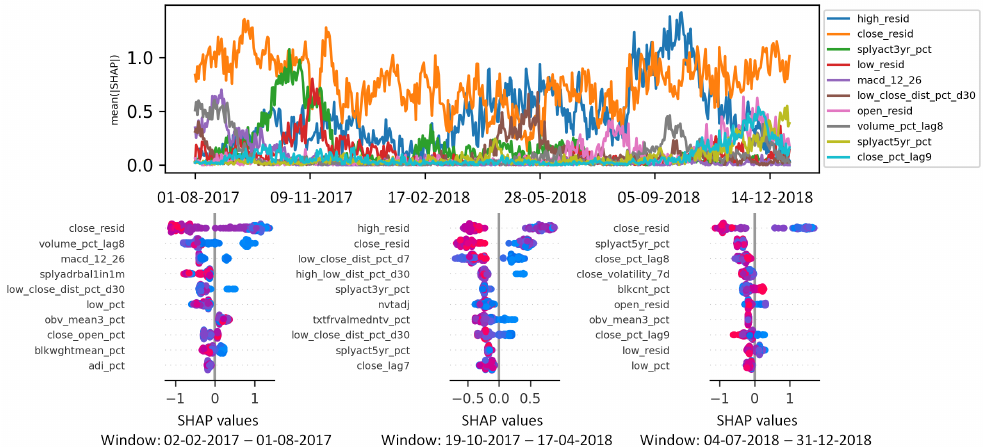
Figure 1. Interactive dashboard snapshot. Uptrend class. LTCUSD. Training window size W =